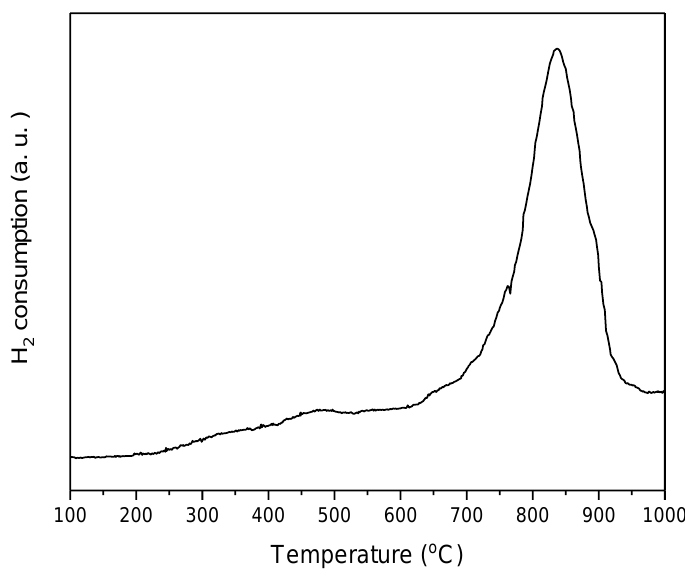
Figure 3. H 2 -TPR profile of Ni-Sn/CeAl.